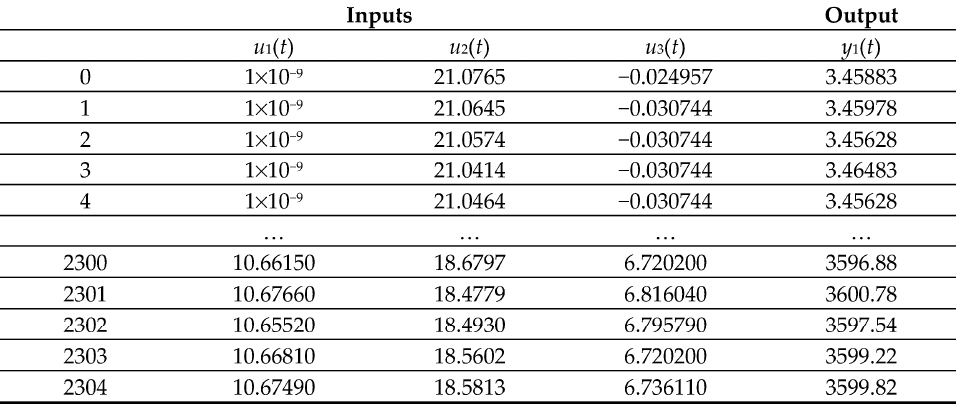
Figure 6. A sample of the dataset.